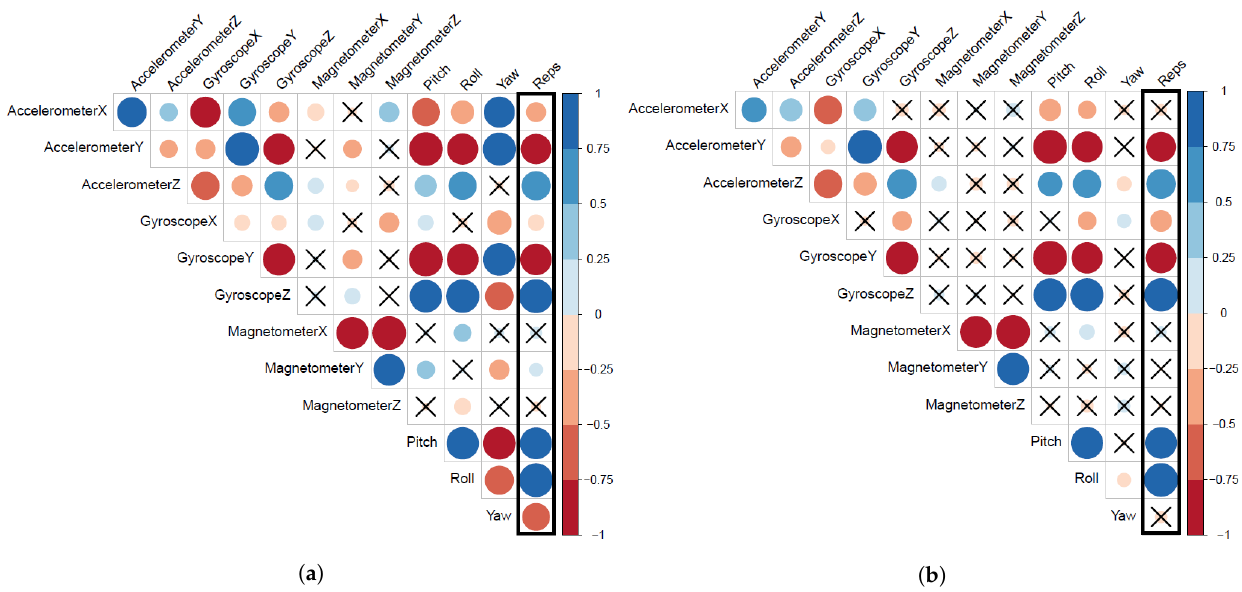
Figure 8. Graphical display of the differences in the correlation matrices of the 12 extracted features (MAD: Mean Absolute Deviation) and the bicep repetitions with and without fatigue. ( a ) Correlation matrix of the 12 MAD features and the bicep repetitions in the non-fatigue subset. ( b ) Correlation matrix of the 12 MAD features and the bicep repetitions in our complete dataset.